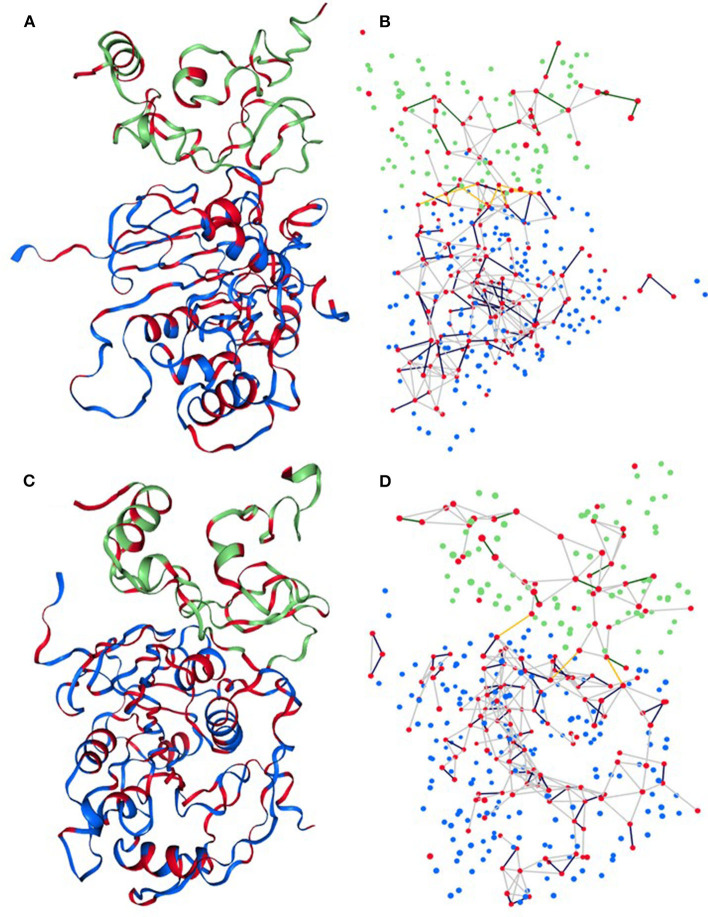
Sub-network representation of network 3D view of (A,B) initial structure and (C,D) final structure of the complex. Each residual Cα atom is represented by a sphere where the red sphere indicates hydrophobic residues. Blue and green color spheres correspond to residues of nsp16 and nsp10, respectively. The yellow line edges represent the contact network of hydrophobic residues between nsp16 and nsp10.